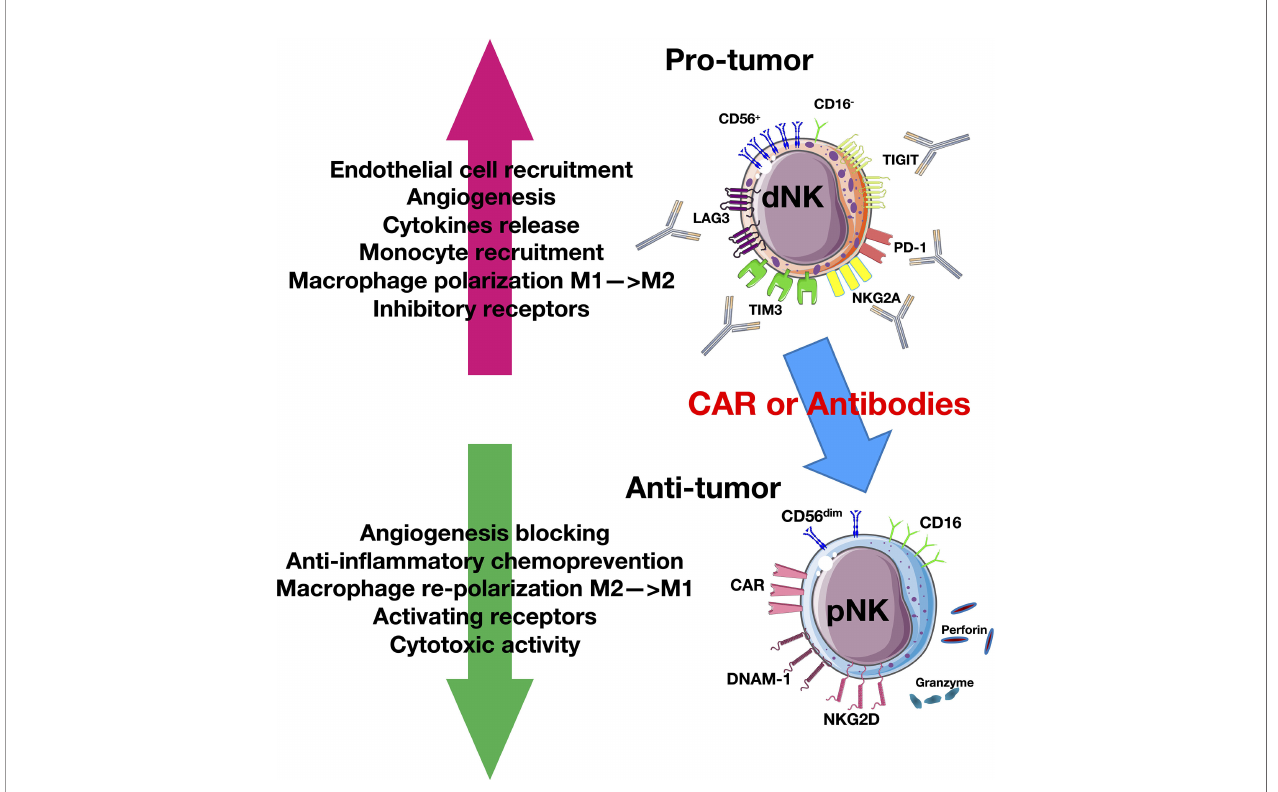
FIGURE 1 | Natural killer cell (NK) plasticity in cancer. Tumor cells and tumor microenvironment (TME) induce a pro-tumor CD56 + CD16 − decidual-like phenotype that expresses inhibitory receptors. The blockade of these receptors or the use of chimeric antigen receptor (CAR) or adaptive therapy can reverse this mechanism by switching NKs into antitumor cytotoxic CD56 dim CD16 + cytotoxic phenotype that can release granzyme and